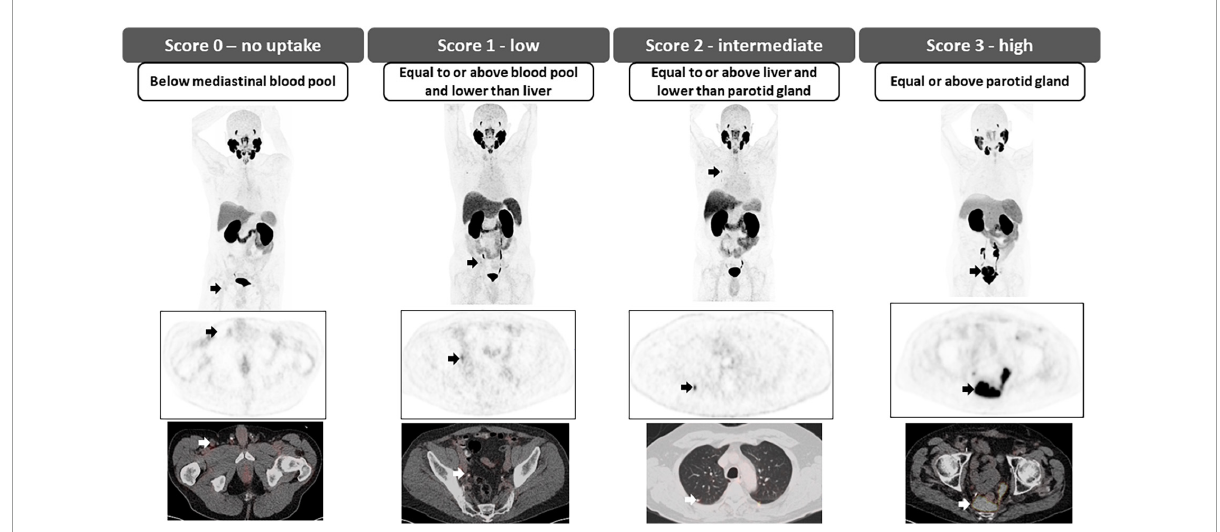
FIGURE6 miPSMA expression score. Examples for the various miPSMA scores are pointed with arrows .